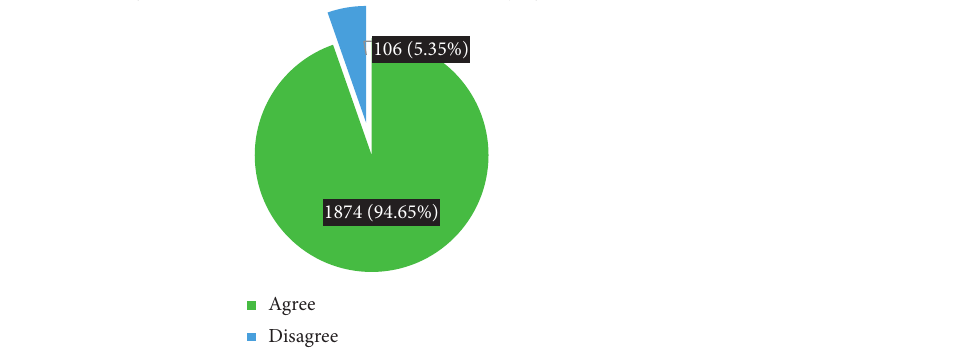
Figure 1: A figure showing frequencies and the corresponding proportions for agreement and disagreement between MUAC vs. WHZ in identifying SAM children following recovery from CMAM, South Gondar Zone, Amhara Region, 017/18 ( n � Table 4: Agreement between MUAC and WFH in Z -score in identifying SAM children by age and sex, South Gondar, Amhara Region, Ethiopia, 2017/18 ( n � 1980). SAM (WHZ < − 3) Not SAM ( ≥ − 3) Total All children